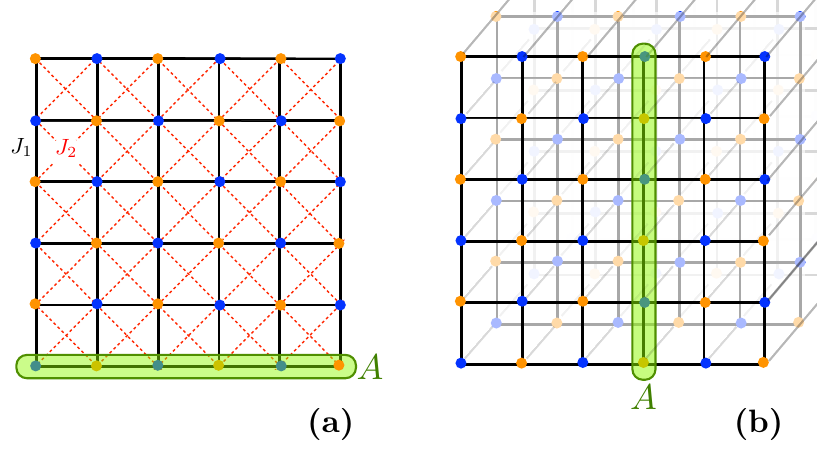
− J Hamiltonian 1 2